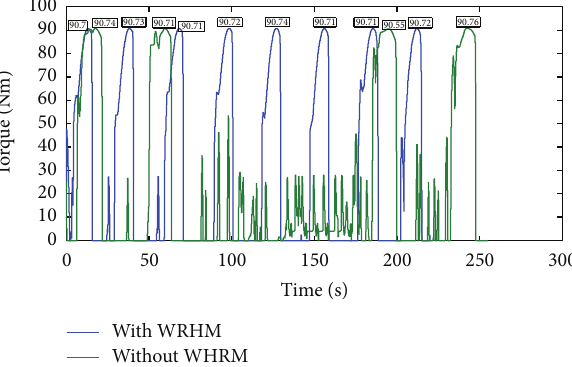
Figure 9: Torque of the experimental vehicle with and without WHRM (value in